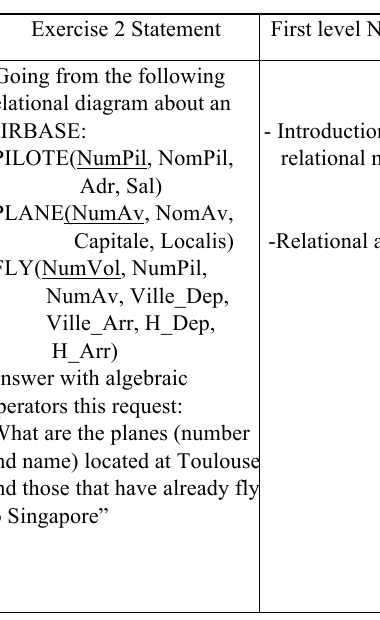
Table 1. Example of bond Exercise-knowledge items-Notions in the case of Relational databases